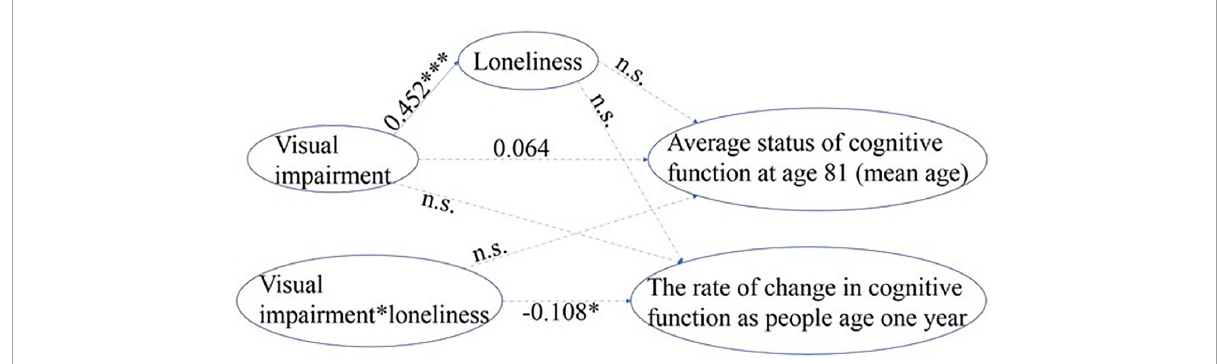
FIGURE3 Standardized path coefficient estimates from the most parsimonious model for visual impairment. a. 1-tailed tests, ∗ p < 0.05, ∗∗∗ p < 0.001. b. The error terms and correlational paths are omitted for clarity. c. The dotted paths with path coefficients shown were remained in the final model but were non-significant, the dotted paths without coefficients were deleted during the process of improving model fit (n.s.).